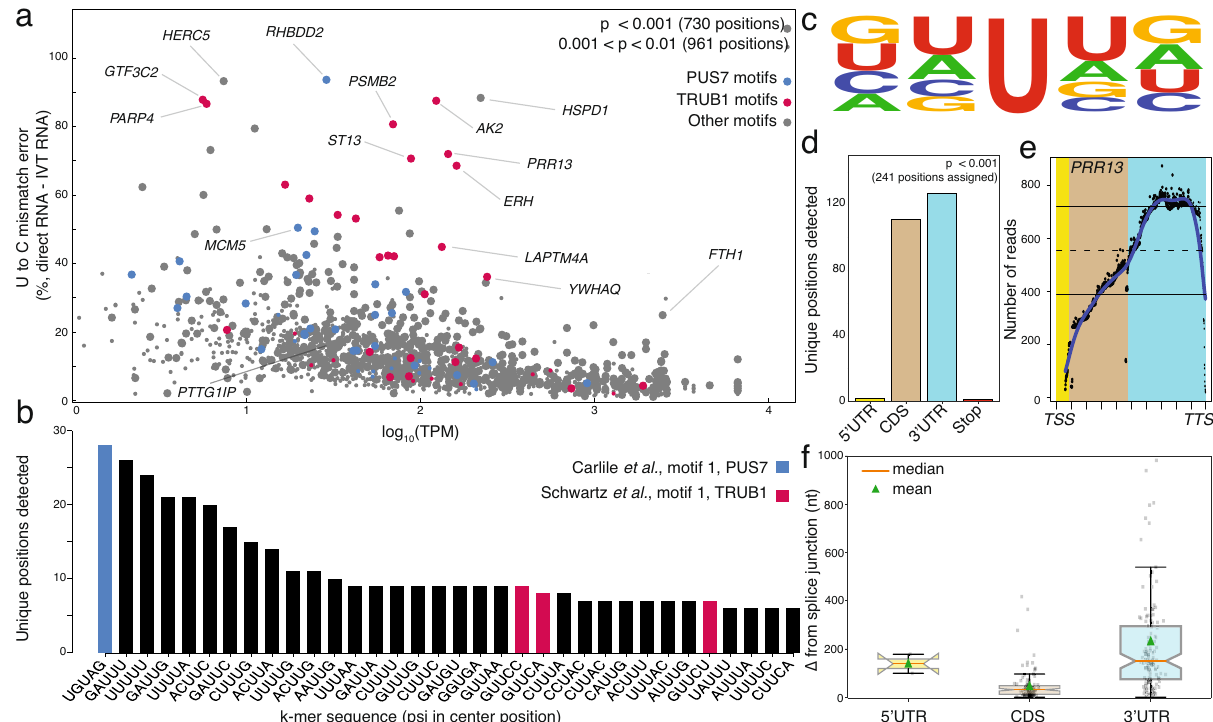
Fig. 4 | Nanopore sequencing detects uridine modi fi cations transcriptome- wide. a The U-to-C mismatches detected by nanopore sequencing versus the − log 10 (TPM) of the merged direct RNA datasets. large dot: the detected targets identi fi edbythesigni fi cancefactoroftwooutofthreebiologicalreplicates. P value was calculated by a one-sided F test (speci fi c formula listed in Methods). 0.001< p <0.01 is de fi ned as signi fi cant and shown with a small dot; p <0.001 is de fi ned as highly signi fi cant and shown with a large dot. blue: Targets with PUS7 motif, red: Targets with TRUB1 motif, and gray: Targets with the motifs other than PUS7orTRUB1. b Thek-merfrequencyofthemostfrequentlydetectedtargetswith highercon fi dence. c Thesequencemotifacrossthedetected ψ modi fi cationforall